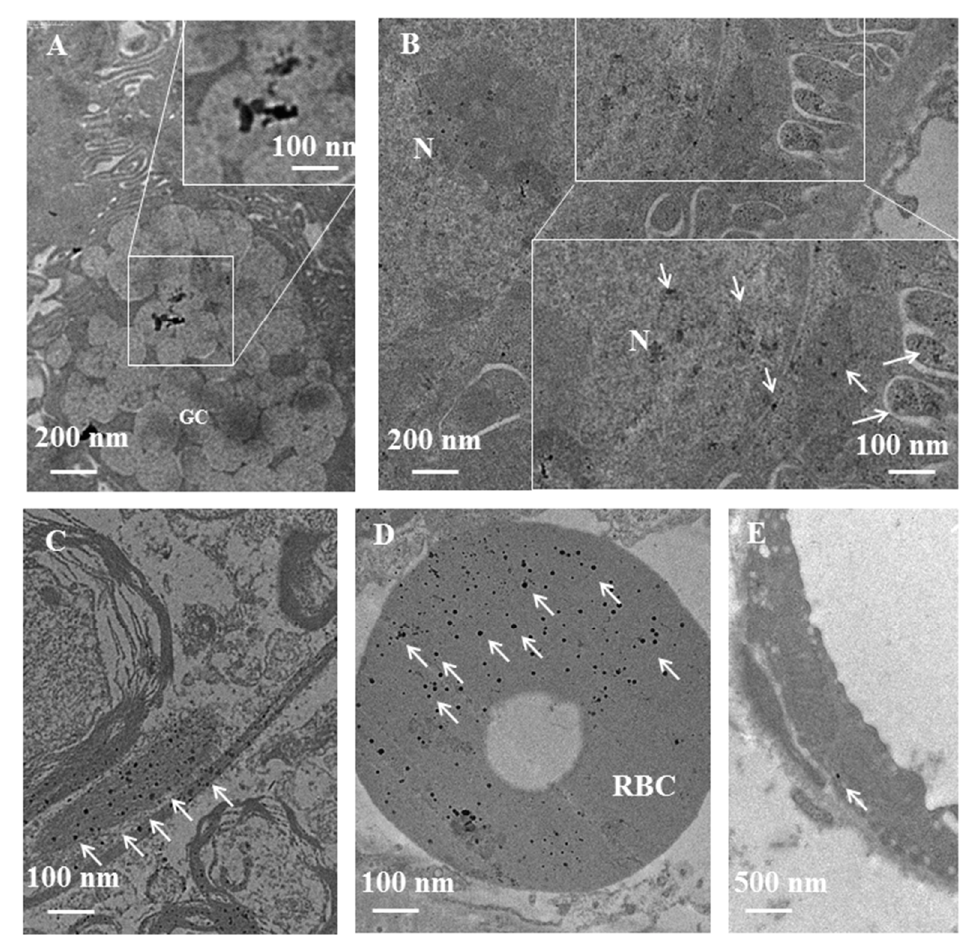
Figure 2. Biodistribution of AgNP-G in a murine model after injection of 10 8 NPs into tail vein. Transmission electron microscopy micrographs of ultrathin sections of mouse organs. White arrows indicate AgNPs as single NPs or as cluster. N: nucleus; GC: goblet cell; RBC: red blood cell; ( A ) intestine; ( B ) kidney; ( C ) brain; ( D ) red blood cell in kidney; ( E ) endothelial cell.